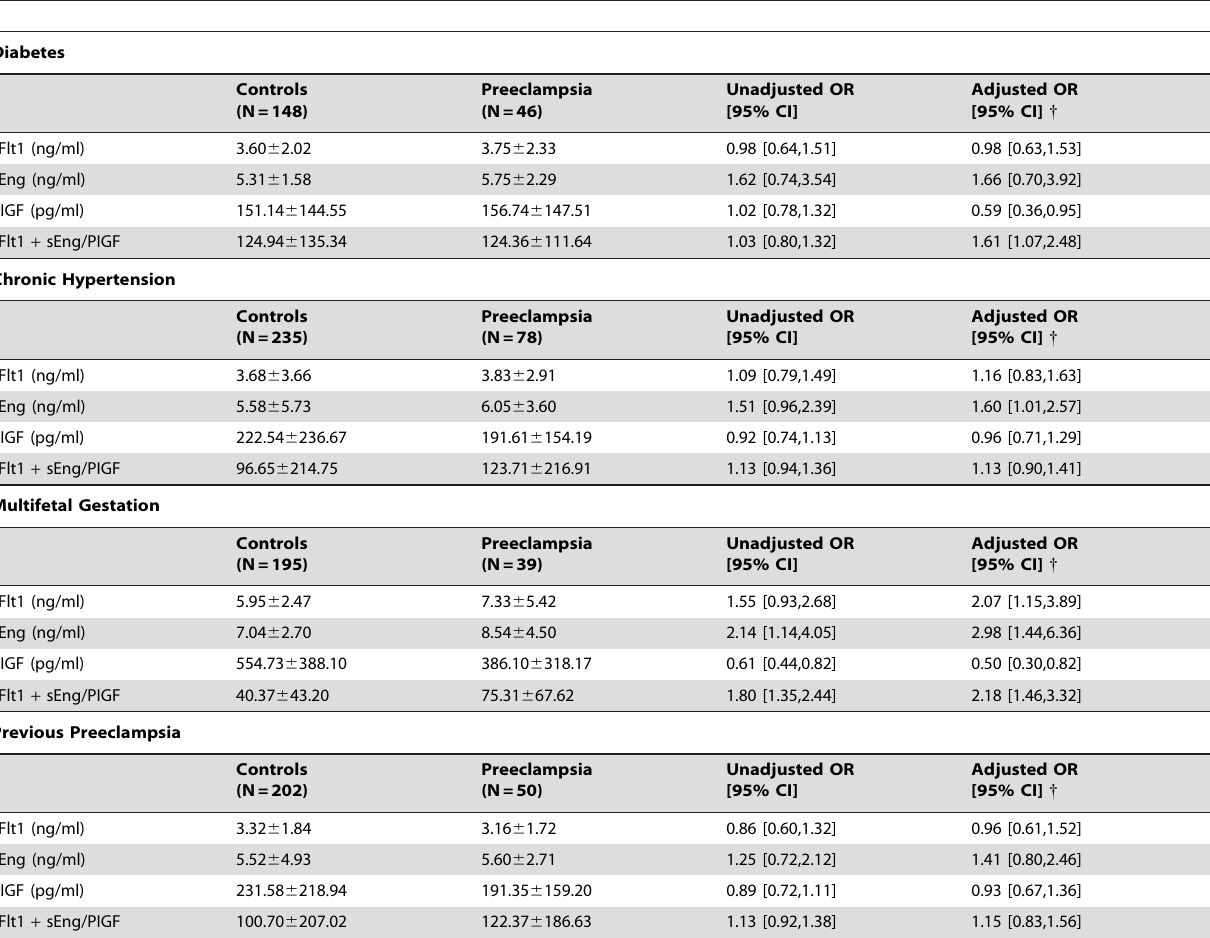
Table 2. Odds Ratios for Preeclampsia According to Circulating Angiogenic Factors Measured in Samples Collected at Study Entry.*